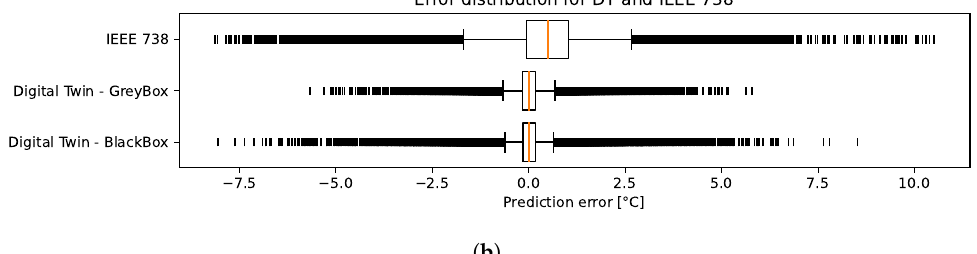
Equation (9) distribution without outliers ( a ) and with outliers ( b ). Refer- Figure 5. Error e t + 1 ˆ y ring with Q i to the i th quartile, an outlier is a value that is above Q3 + 1.5 (Q3 − Q1) or below Q1 − 1.5 (Q3 − Q1). The result is coherent with Figure 4: the grey-box shows less variance, particu- larly with the outliers. Its error is rarely greater than 5 degrees in absolute value.